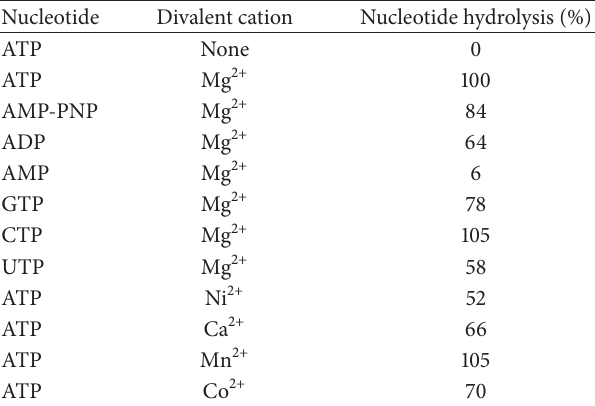
Table 2: Relative hydrolysis rates of different nucleotides by Lon- like-Ms and the effects of divalent